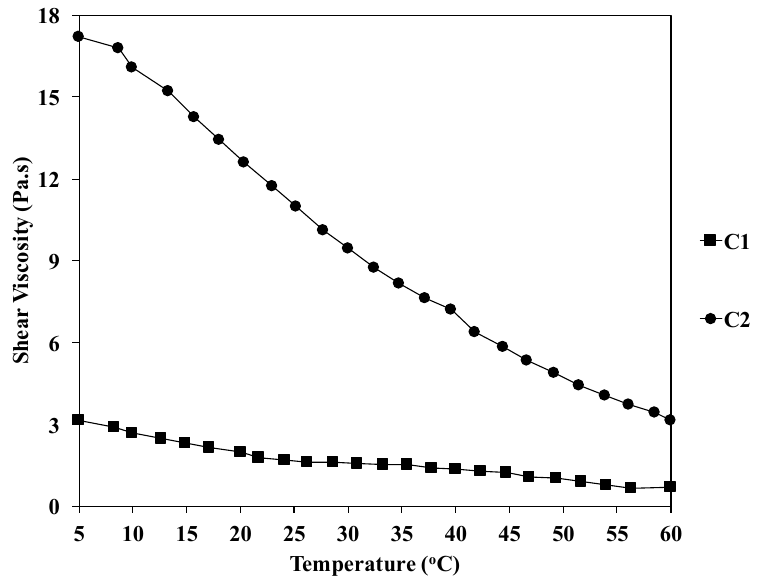
Figure 3. Effect of temperature on the viscosity of chitin solutions at different concentrations. Table 1. Characteristics of chitin solutions and fiber prepared at different temperatures of the water coagulation bath. Temperature (°C)